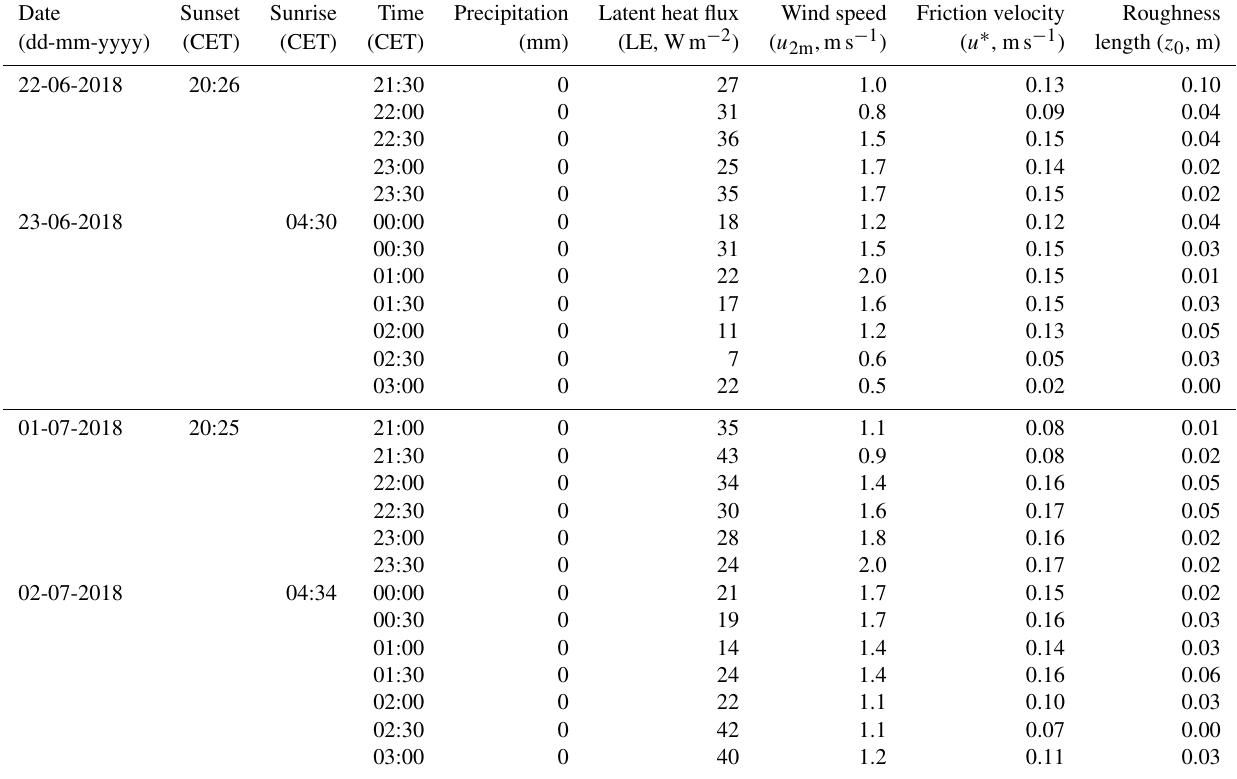
Table D1. Computing the roughness length ( z 0 ) at the Chamau site from wind speed ( u 2m ) and friction velocity ( u ∗ ) on neutral nights. Date Sunset Sunrise Time Precipitation Latent heat flux Wind speed Friction velocity